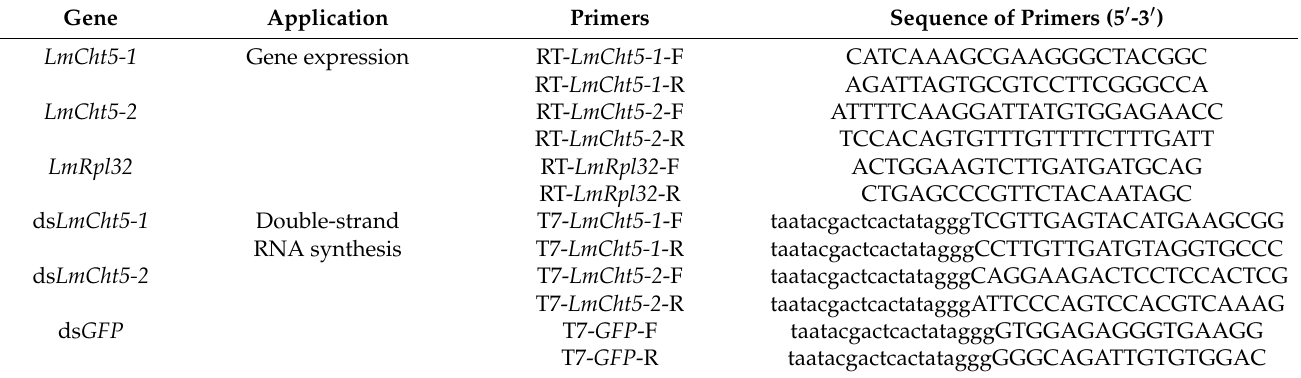
Table 1. Sequence of